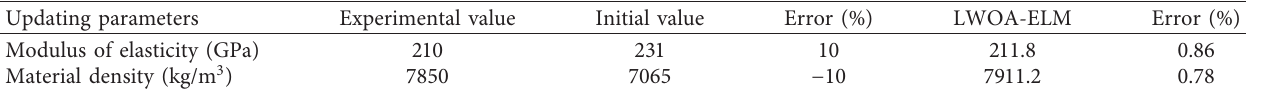
Table 5: Values and errors of the updated parameters with 5%